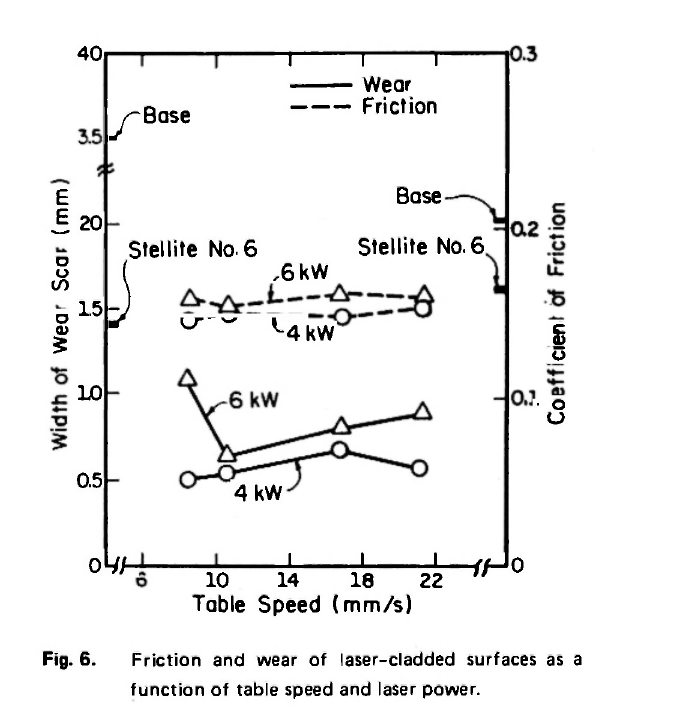
Fig. 6. Friction and wear of laser-cladded surfaces as a function of table speed and laser power.